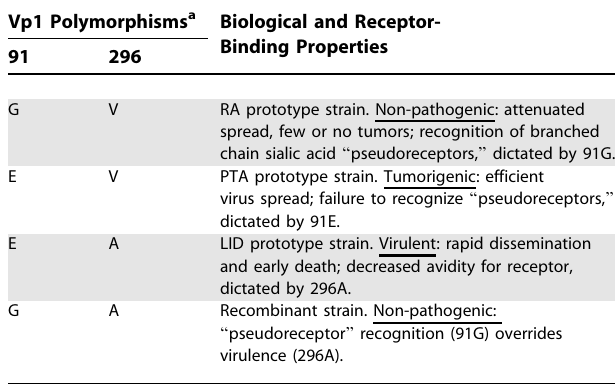
Table 1. Determinants of Pathogenicity in the Sialic Acid Binding Pocket of